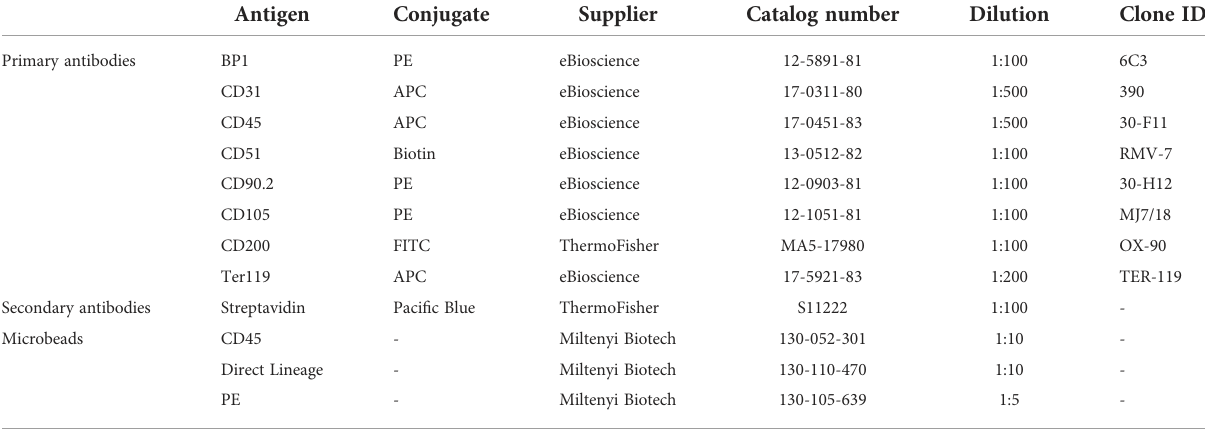
TABLE 1 List of antibodies and microbeads used for fl ow cytometry analysis or MACS